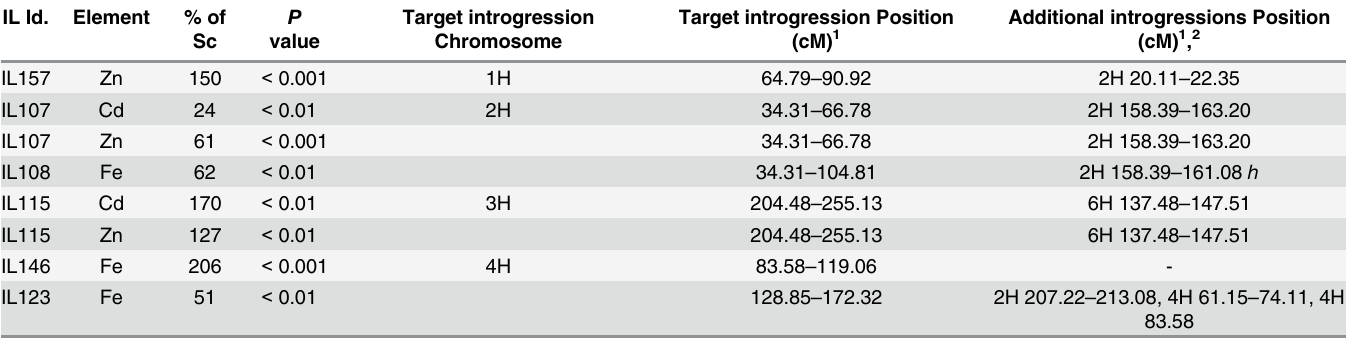
Table 1. QTL for Cd, Zn and Fe concentrations in mature grains. Magnitude of effect of each QTL is expressed as percentage of the concentration found in the parent genotype Scarlett (% of Sc). IL Id.